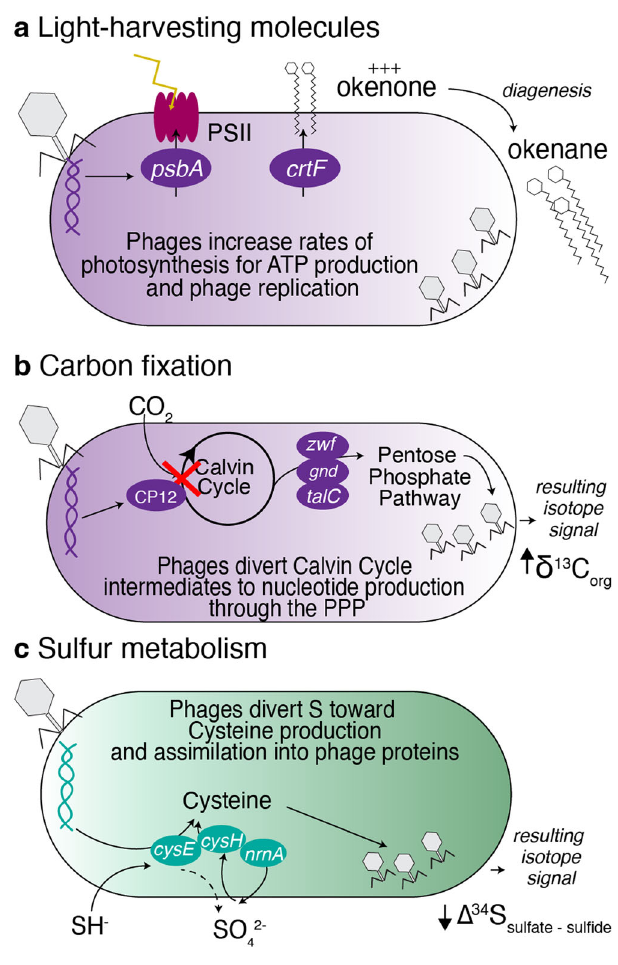
Fig. 5 Conceptual hypotheses for viral infection in fl uence on PSB and GSB communities. Viral infection and gene transfer affect the biosignatures of PSB and GSB by modulating their ( a ) pigment production, ( b ) carbon fi xation, and ( c ) sulfur